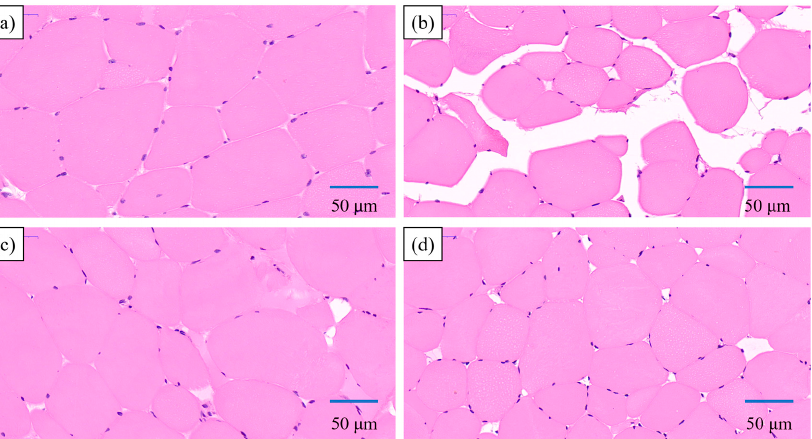
Figure 6. Observation of morphology and distributions of ice crystals in ( a ) fresh meat, ( b ) frozen meat, ( c ) frozen meat pretreated with trehalose (meat + trehalose), and ( d ) frozen meat pretreated with COS (meat + COS) samples after freezing in the view of the cross-section to the muscle fibers. The meat fibers were colored in red by eosin, and the nuclei of muscle cells were stained blue by hematoxylin, while the voids (white zones) represented the location of the ice crystals.